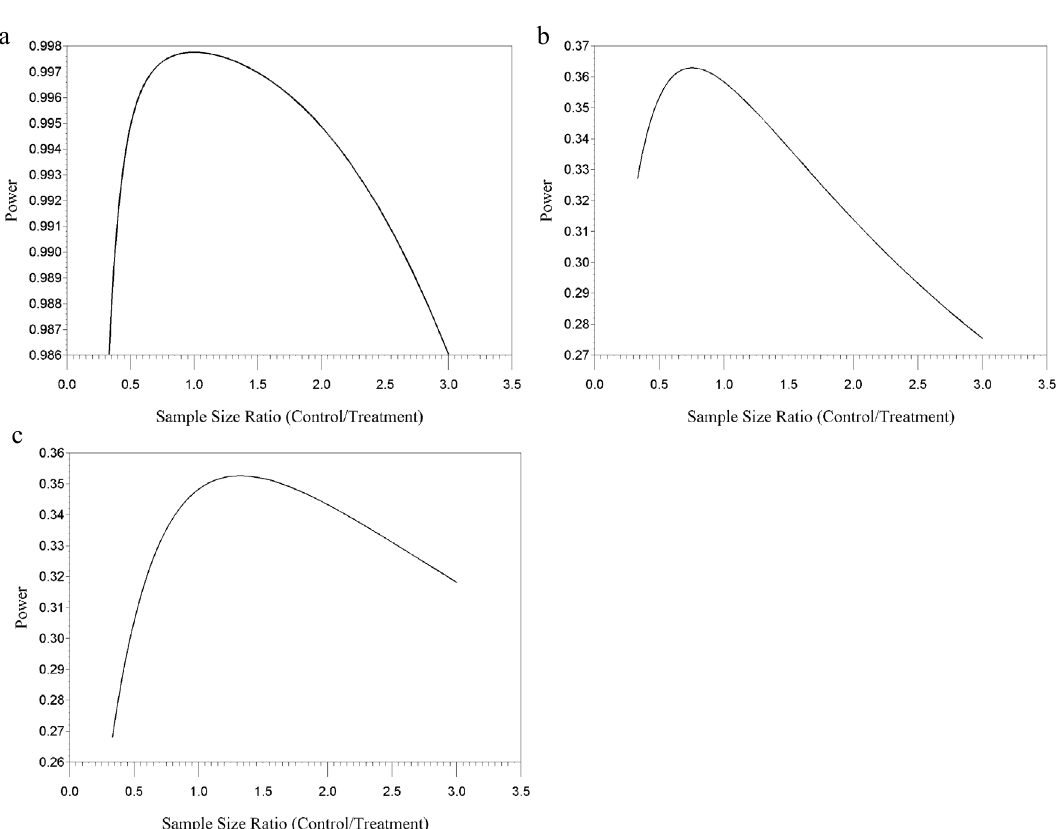
Figure 2. ( a ) Power of the test using single-block design for the pup weight endpoint for varying control-to-treatment sample size ratios assuming combined male and female pups, µ = 6.5, µ = 5.9, ρ = 0. 60, ψ = 7.59 and n + n = 100; ( b ) Power of the test using c t c t , single-block design and linear model for the prenatal loss endpoint for varying control-to- = 0.08, µ = 0.15, ρ = 0.19, ψ = 3.2 3, and n + n = treatment sample size ratios assuming µ c t c t 100; ( c ) Power of the test using single-block design and logistic model for the prenatal loss = 0.08, µ = 0.15, endpoint for varying control-to-treatment sample size ratios assuming µ c t ρ = 0.19, ψ = 3.2 3, and n + n c t